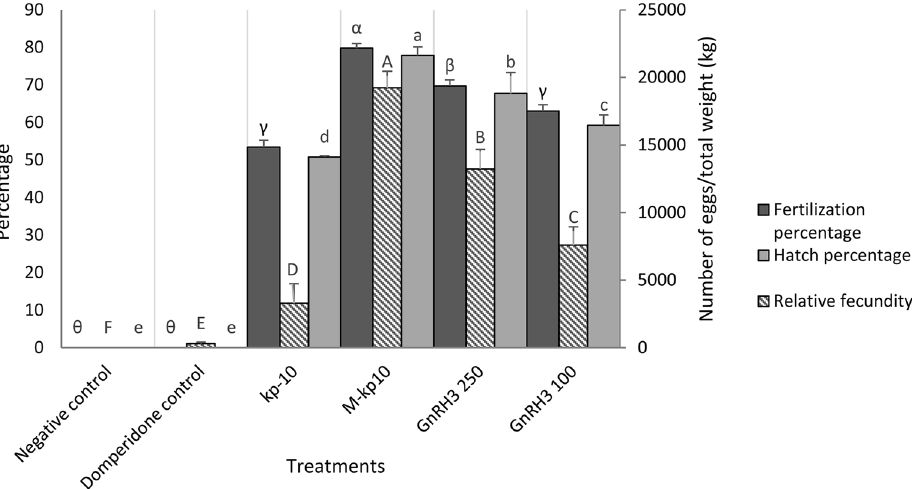
Figure 7. Relative fecundity, percentage of fertilization and hatching in the female goldfish treated with kp-10, M-kp10 and GnRH3. The different letters above columns are showing significant differences based on one-way ANOVA and Tukey’s post hoc